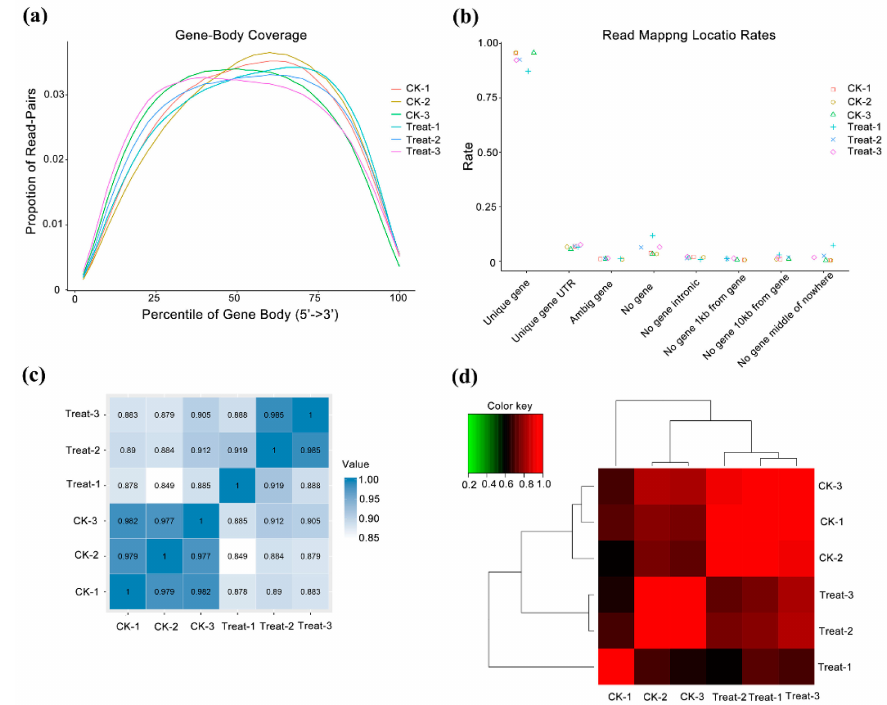
Figure 2. Quality control of transcriptome data and analysis of samples repeatability. CK means the control group (sampled at 15 ◦ C), treat means the treatment group (sampled at − 4 ◦ C). ( a ) Random- ness assessment of reads on reference genome. The abscissa is the relative position of the gene, the ordinate is the ratio of reads in the total aligned reads in the corresponding position interval, and different colors represent different samples. ( b ) Sample correlation analysis. This is a heatmap of the Pearson correlation coefficients between samples calculated based on all genes; the darker the color, the better the correlation between the two samples. ( c ) Cluster analysis between samples. ( d ) Sample correlation matrix